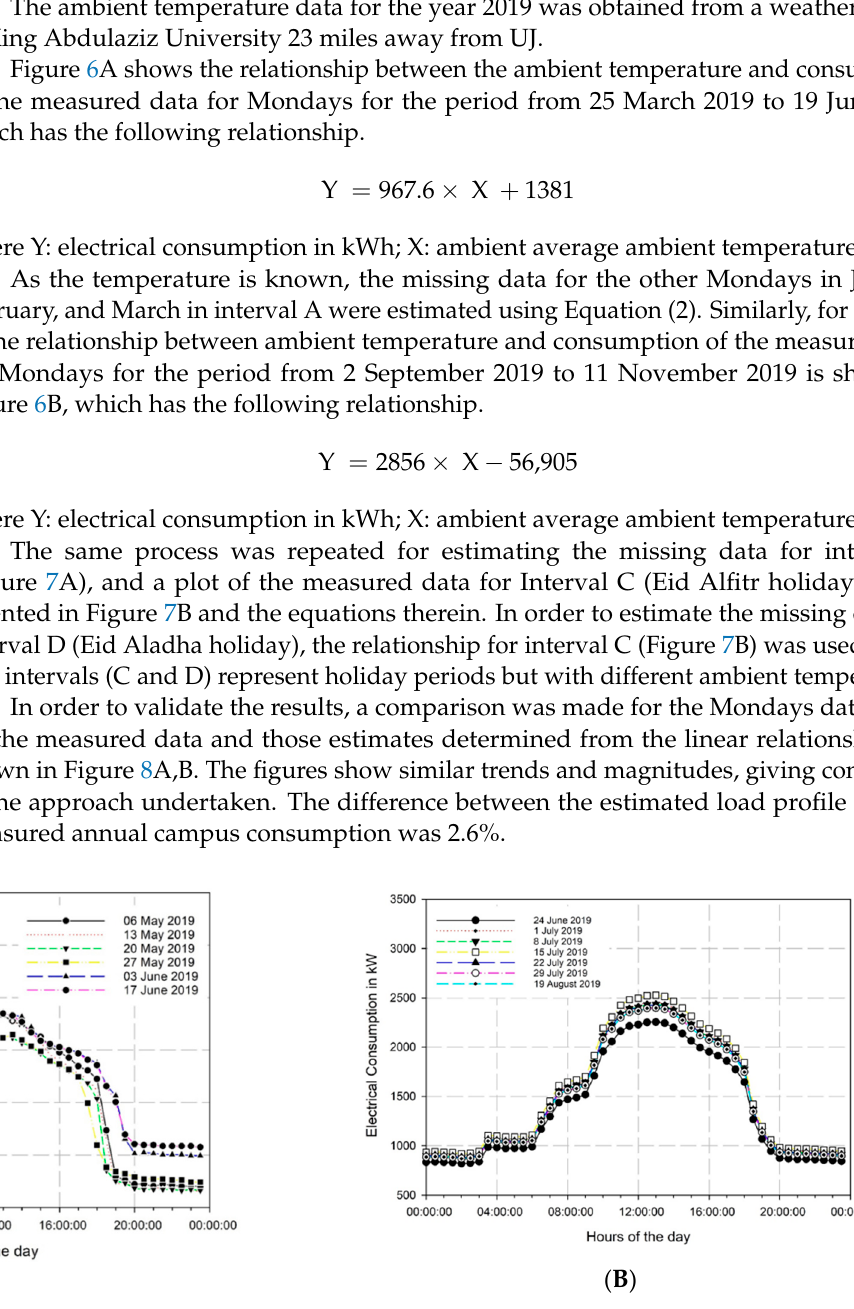
Figure 9. University of Jeddah load profile per hour for the year of 2019. Red represents available data (Figure 5) and black represents missing data. Different intervals as per Table 2 are also shown. 4. Modelled Energy Supply Scenarios The University of Jeddah currently uses fossil fuel-derived electricity with high CO 2 emissions. The aim here is to provide a range of PV technical solutions coupled with eco- nomic feasibility that can reduce/negate the emissions and provide savings for the univer- sity. The annual electricity consumption of the UJ campus was 9939 MWh in 2019. The import tariff for this is USD 9.775 c/kWh including 15% VAT. To evaluate the displace- ment of such a supply through the deployment of solar PV power generation systems, different scenarios were developed and modelled. The modelling was undertaken using the commercial software package knows as Homer (Hybrid Optimization of Multiple Electric Renewables), which is appropriate for the analysis [15]. This simulation software was designed to help energy specialists make decisions on optimised system configura- tions to supply specific loads. The optimisation includes an energy balance when using